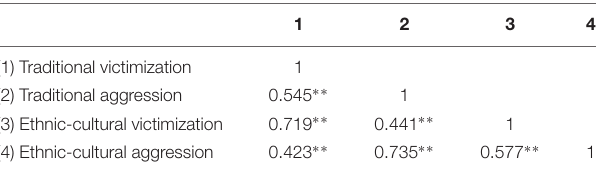
TABLE 3 | Spearman’s rho – Traditional and ethnic-cultural bullying.